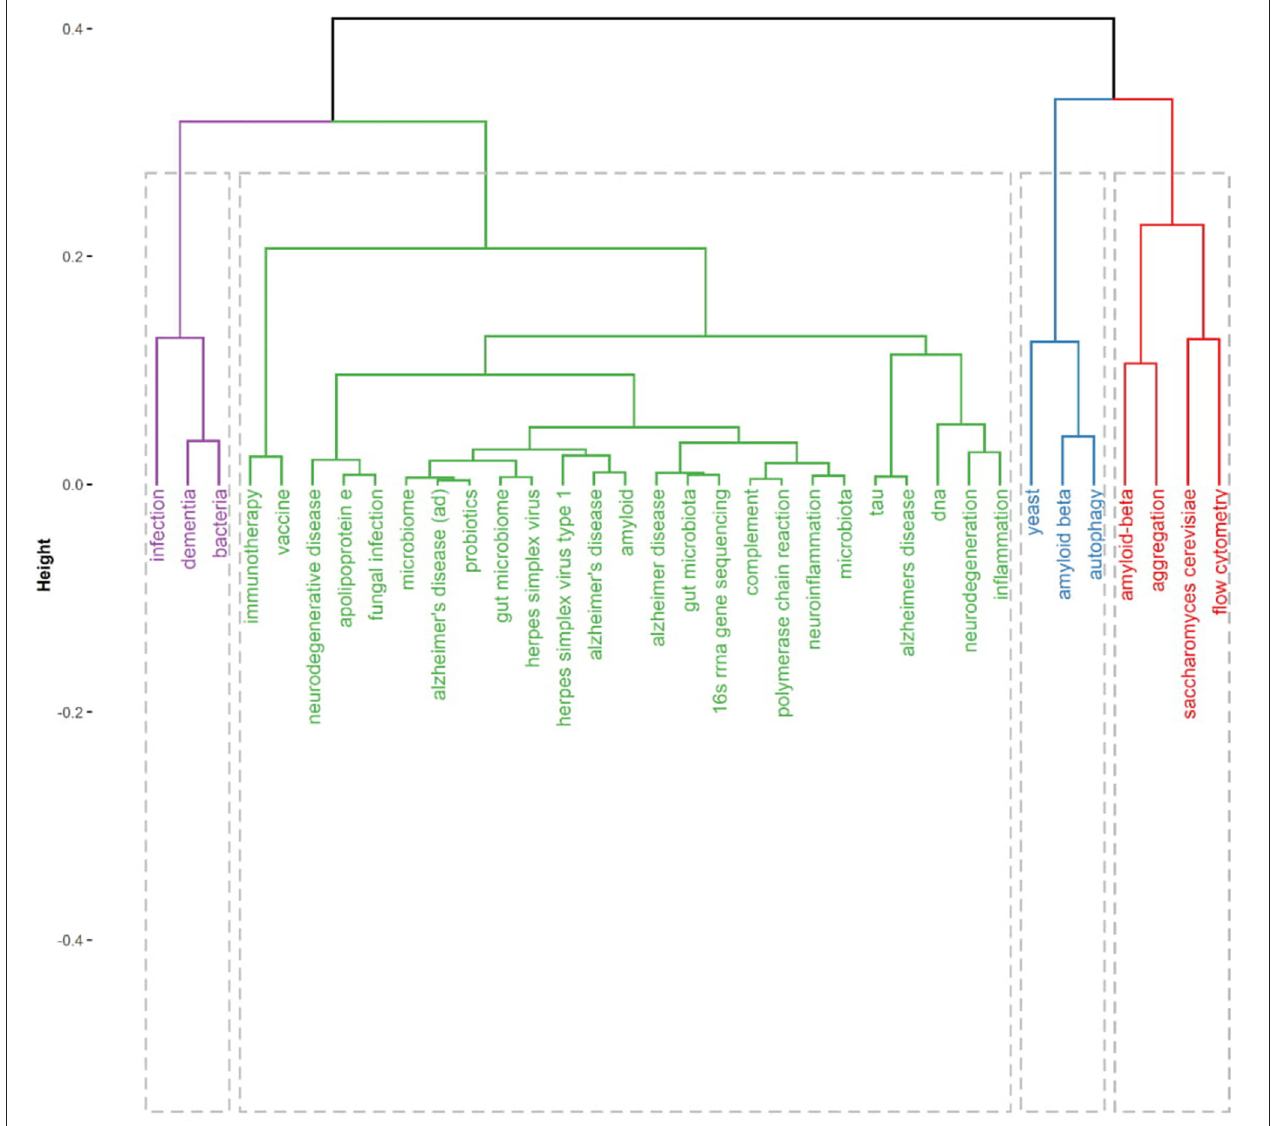
FIGURE 4 | Thematic area and conceptual landscapes in MPP-AD research.